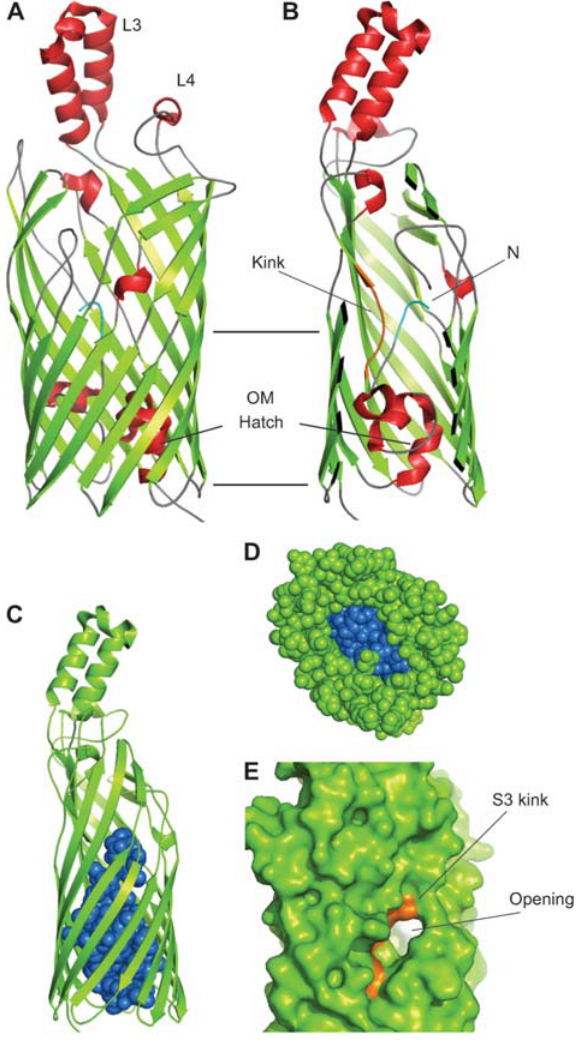
Figure 1 Structure of E. coli FadL. (A) Cartoon representation viewed from the side, with b -strands colored green, helices red and loops gray. Extracellular loops L3 and L4 are indicated. The N-terminus (residues 1–5) is colored cyan. The approximate positions of the OM interface regions are indicated by horizontal lines. (B) Cut-away view from the side, 90 8 rotated relative to (A). The kink in b -strand S3 (residues 99–107) is colored orange. (C) View as in (B), showing the hatch domain occupying the lumen of the barrel as a space-filling model in blue. (D) Space-filling view from the periplasmic side, demonstrating that the hatch domain fully occludes the FadL barrel. (E) Side surface view of the region surrounding the lateral opening between strands S2 and S3. All images were made with PyMOL